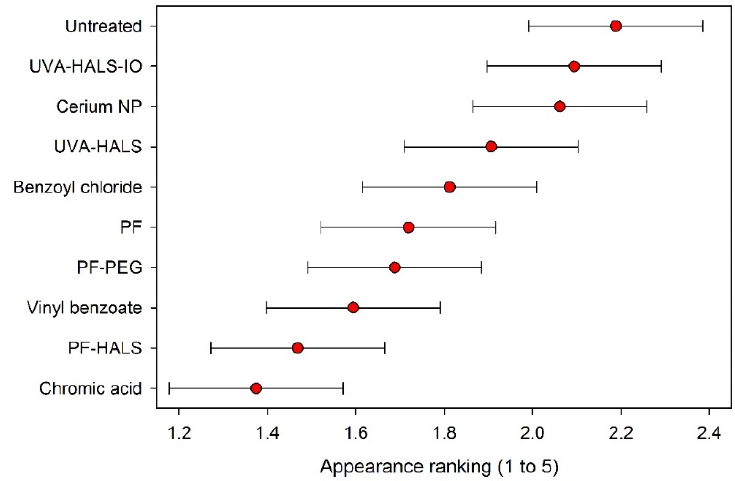
Figure 5. Appearance ranking of the enhanced acrylic and alkyd coatings on chemically modified or treated yellow cedar wood panels exposed to the weather in Australia for 2 years.